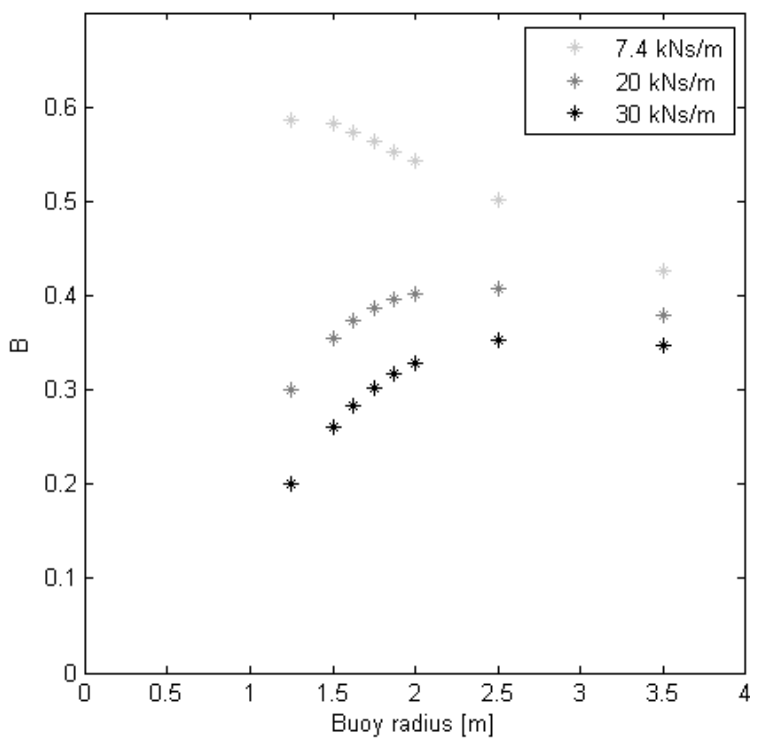
Figure 5. Velocity ratio B as a function of buoy radius has been simulated for three levels of γ . The draft has been kept constant at 0.4